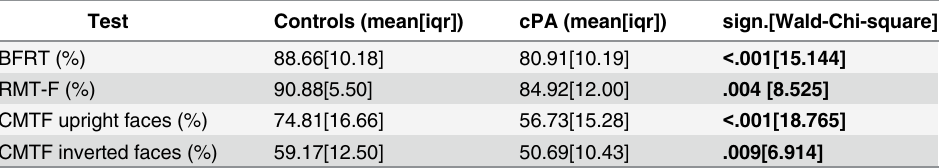
Table 1. Face recognition tests for controls and individuals with Prosopagnosia.